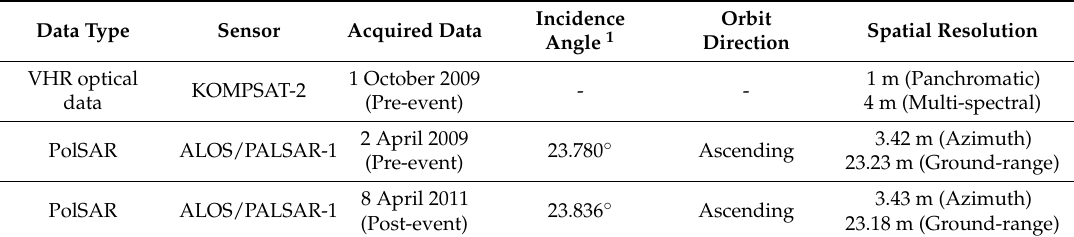
Table 1. Description of the remote sensing data.